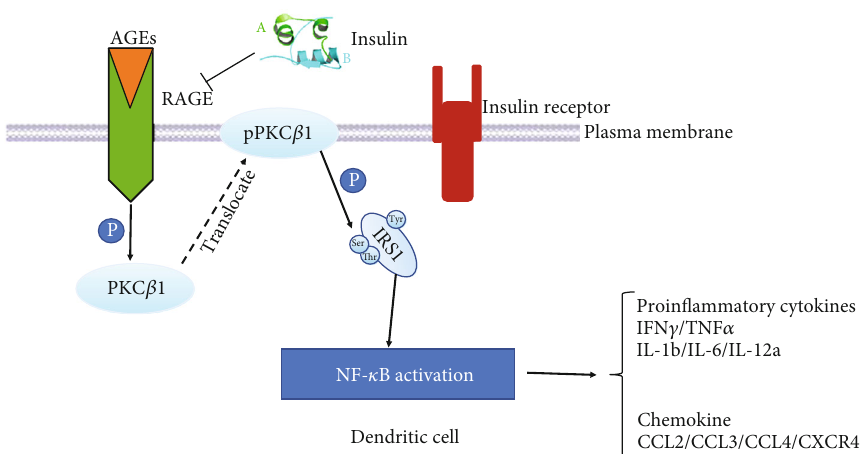
Figure 7: AGEs-BSA-stimulating DCs to increase RAGE expression, followed by promoted phosphorylation of PKC β 1 and serine phosphorylated IRS1 and activated NF- κ B and upregulated proin fl ammatory genes; insulin therapy attenuating AGEs-BSA-induced in fl ammatory response of DCs partly by inhibiting RAGE expression, dephosphorylation of PKC β 1, and serine residue of